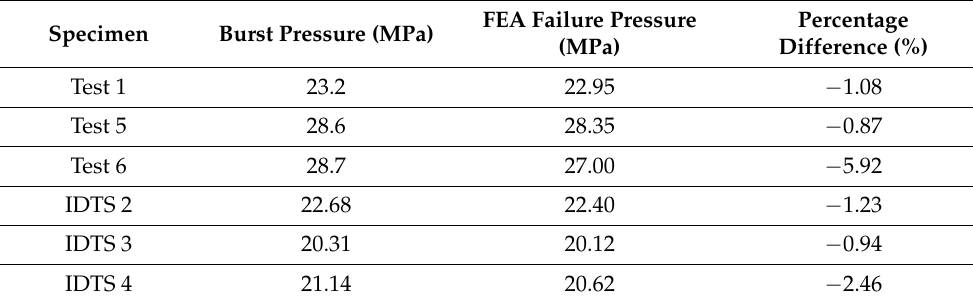
Table 7. FEM validation against full scale burst tests by Bjorney et al. and Benjamin et al.